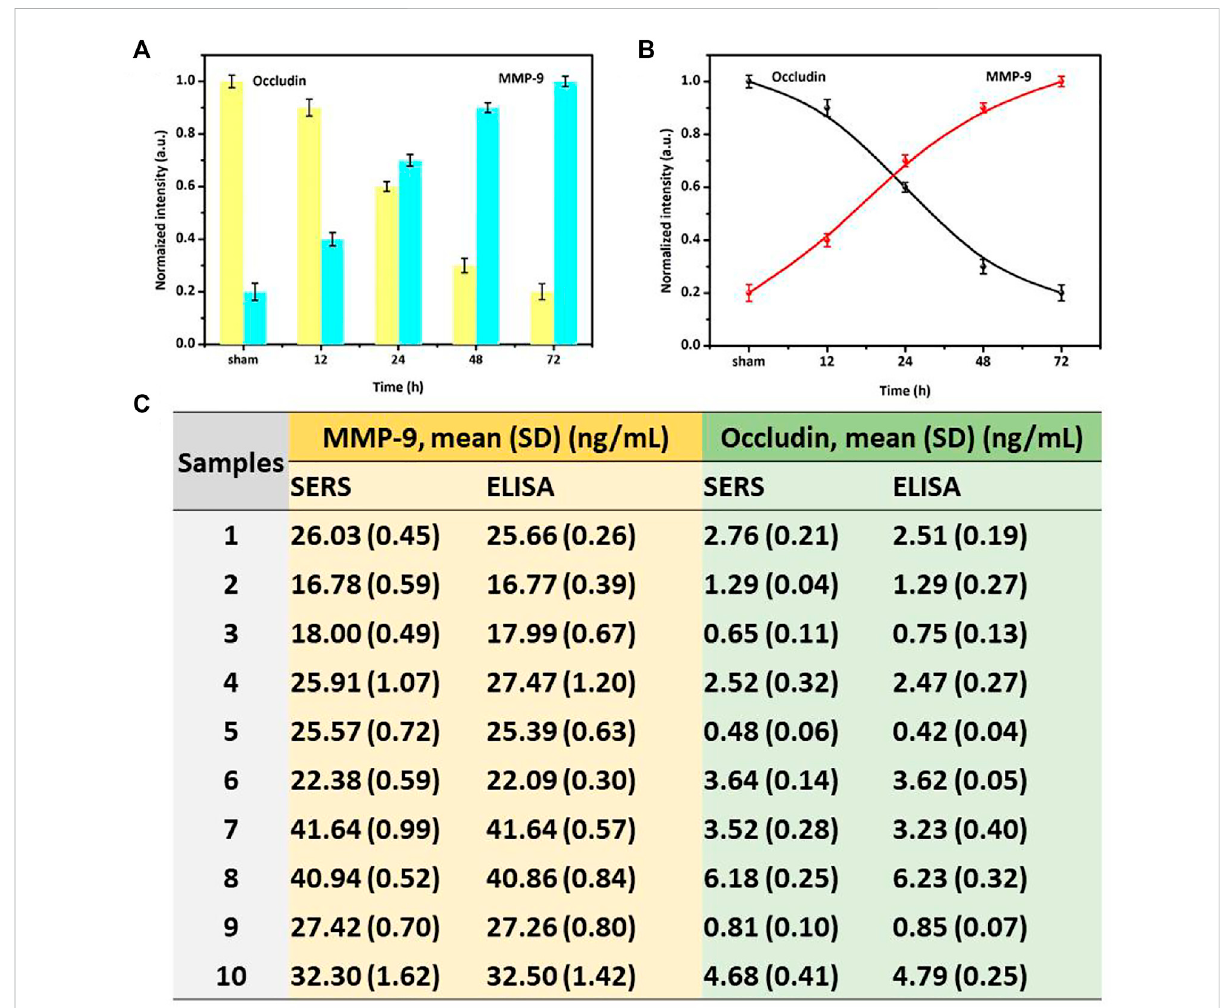
FIGURE 5 (A) Speci fi c-normalized SERSintensitiesand (B)